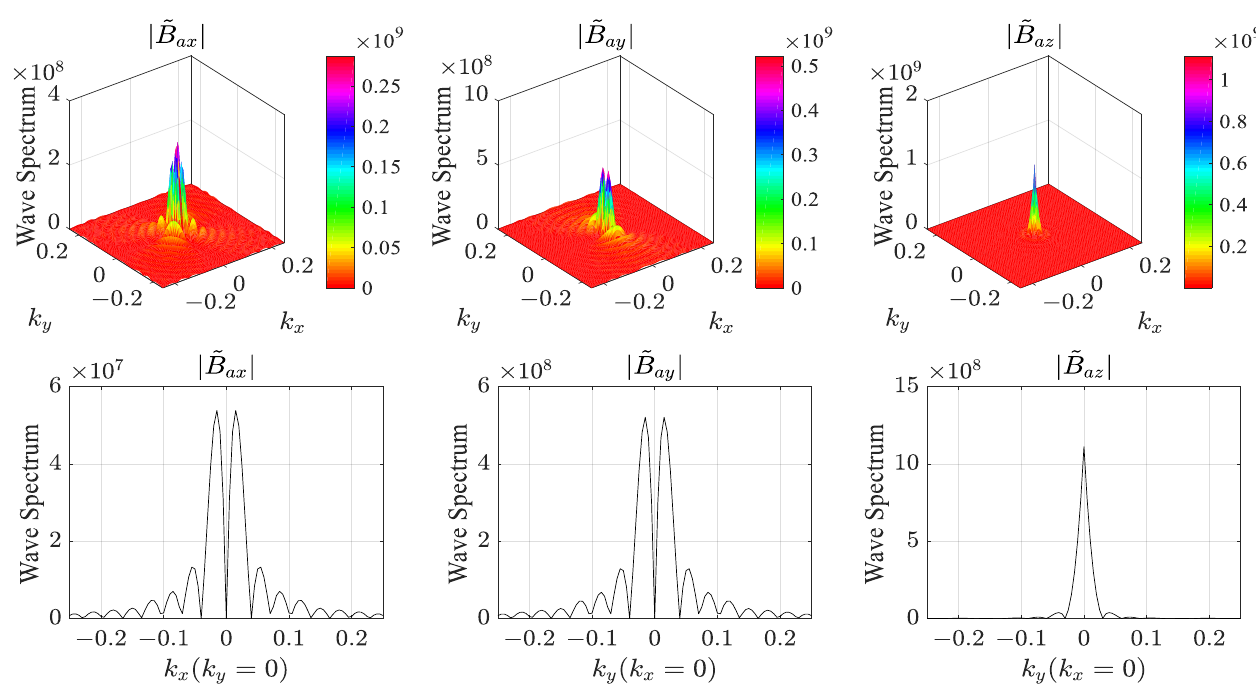
Figure 14. Spectrum distribution of strong magnetic field at different depths. The horizontal ordi- nate of figures ( a , c , e ) is non-logarithmic, and the horizontal ordinate of figures ( b , d , f ) is logarithmic.